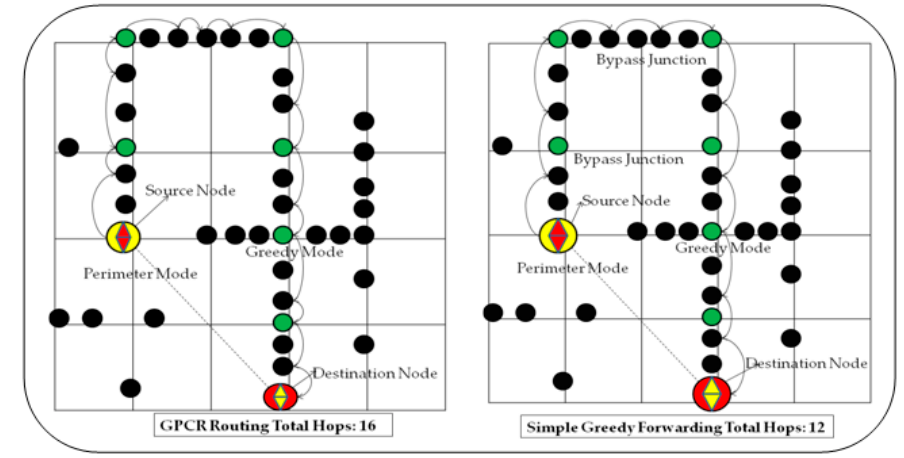
Figure 8. GPCR Inefficiency.